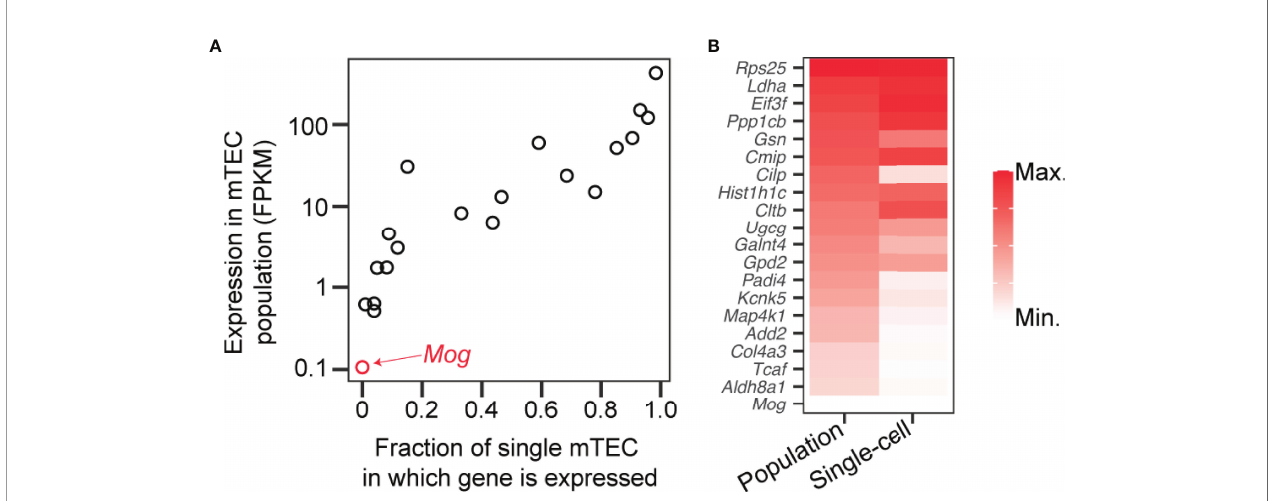
FIGURE 3 | Low expression of Mog compared to self-antigens known to induce T-reg cell development in the thymus. (A) Transcripts encoding myelin oligodendrocyte glycoprotein ( Mog ) and 19 self-antigens known to induce thymic T-reg development (4 – 6) were measured by RNA sequencing of mTEC at the population level ( y -axis) (52) and in 305 single cells ( x -axis) (63). FPKM, fragments per kilobase of exon per million mapped fragments. (B) Transcription levels of the 20 genes represented in (A) in the mTEC population (left) and in single mTEC (right) with red shading according to the scales shown on the axes in (A)